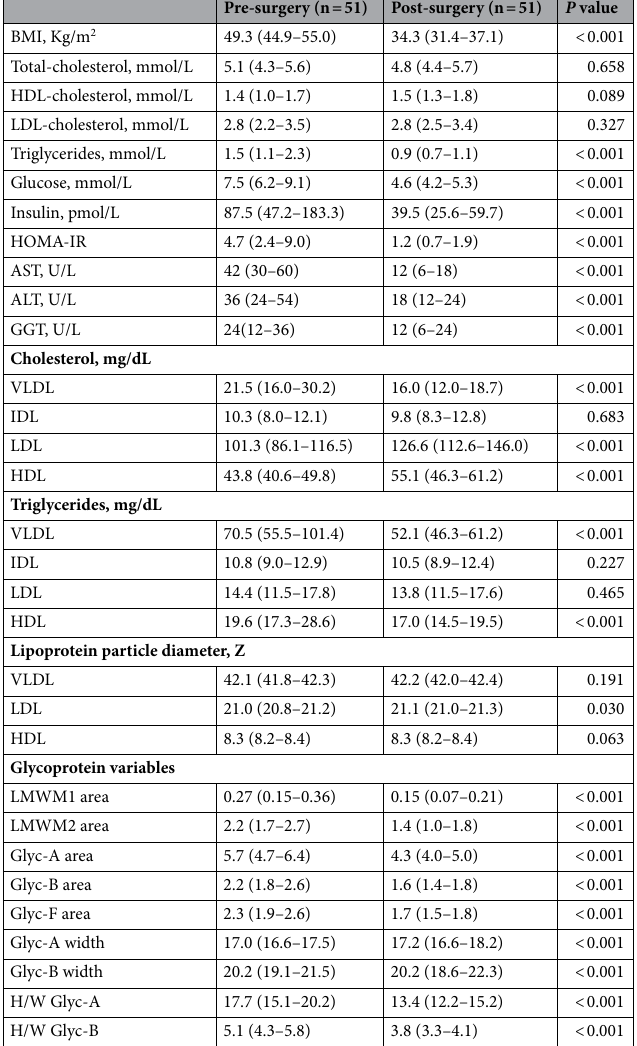
Table 3. Clinical characteristic and serum cholesterol and triglyceride concentrations in lipoprotein fractions, lipoprotein particle diameter and glycoprotein variables in patients with NASH pre- and post- laparoscopic sleeve gastrectomy. Values are shown as medians and interquartile ranges. P value calculated by the Wilcoxon signed-rank test. ALT alanine aminotransferase; AST aspartate aminotransferase; BMI body mass index; GGT γ-glytamyl transferase; HOMA-IR homeostatic model assessment of insulin resistance; HDL high-density lipoproteins; IDL intermediate-density lipoproteins; LMWM low molecular weight molecules; LDL low-density lipoproteins; VLDL very low-density